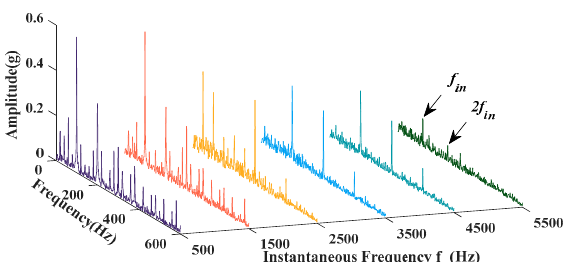
Figure 4. The envelope spectrums of filtering signals by ACMD with different f c .